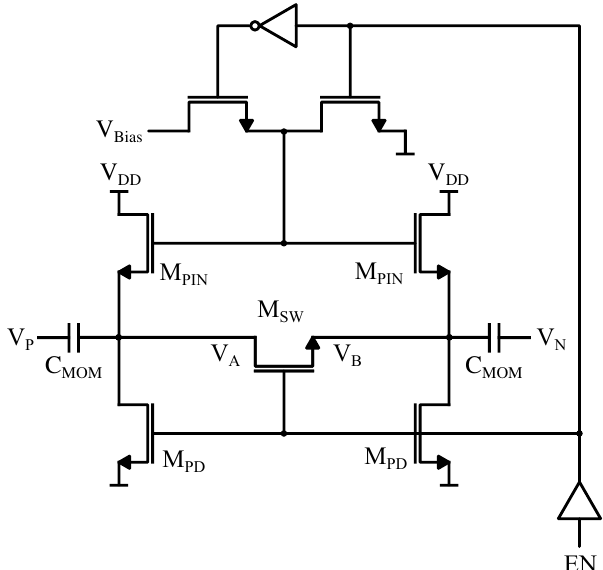
Figure 4. Digitally switched capacitor cells with bottom-pinning biasing [26]. When the main switch transistor M SW is turned off, the NMOS pinning devices M PIN fix the minimum of the oscillation voltage waveform close to the negative supply